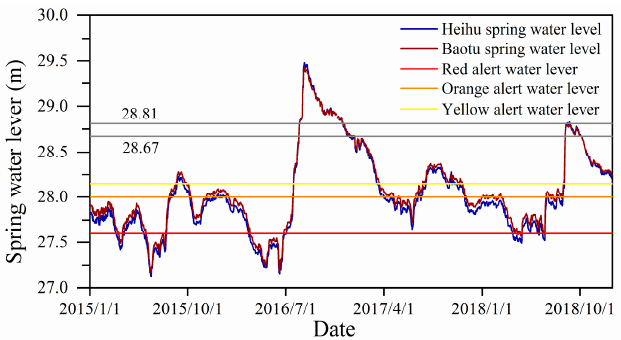
Figure 11. Water level duration curve of the Heihu Spring and Baotu Spring.